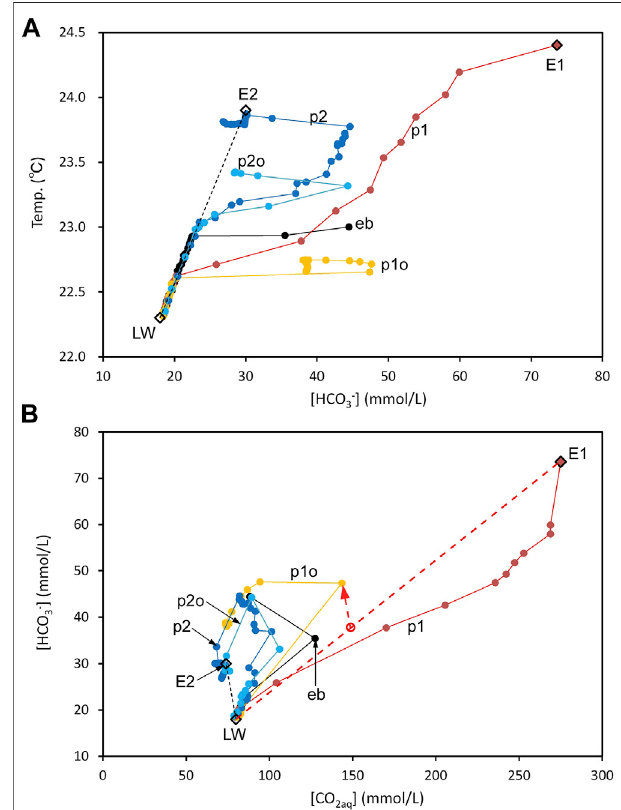
FIGURE 8 | Correlations among the temperature, [HCO 3 ‾ ], and [CO 2aq ] in lake water below − 95 m depth. (A) Correlation between temperature and [HCO 3 ‾ ]. LW is the end-member representing lake water. E2 is the end- member representing lake water reacted with postulated FeCO 3 particles. E1 is the end-member representing lake water at the bottom of D1. (B) Correlation between [HCO 3 ‾ ] and [CO 2aq ]. The red dashed line and arrow indicate the formation process of water located above the line connecting LW and E1, namely, a simple mixture between LW and E1, followed by the reaction with postulated FeCO 3 particles suspended in the lake